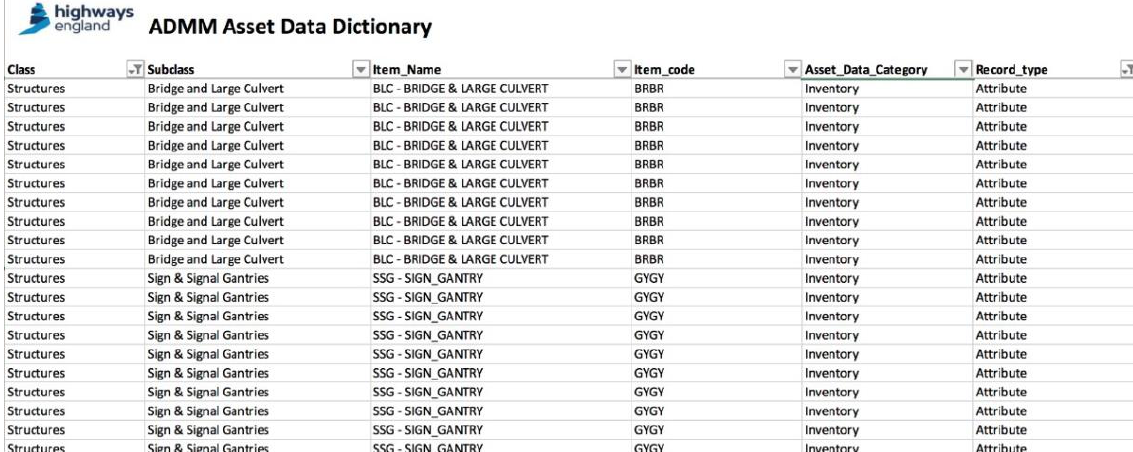
1. This statement derives from discussions with representatives of Costain